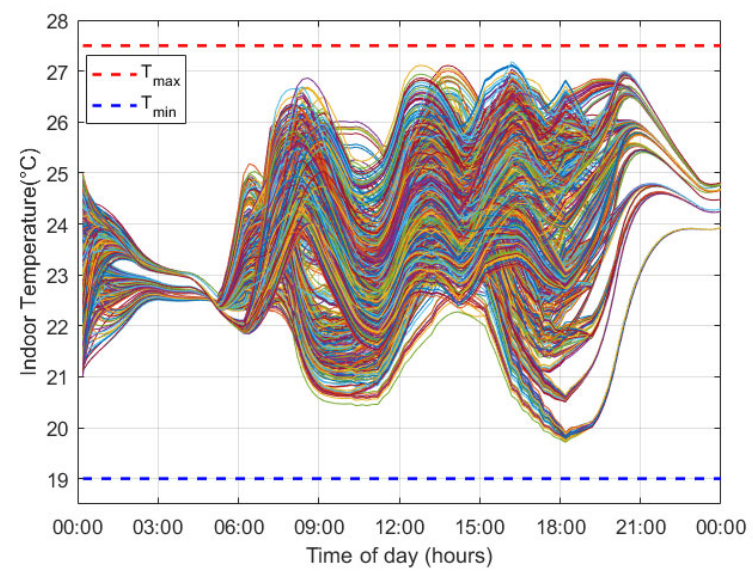
Figure 10. Internal temperatures of all buildings’ thermal zones (optimization level 1).